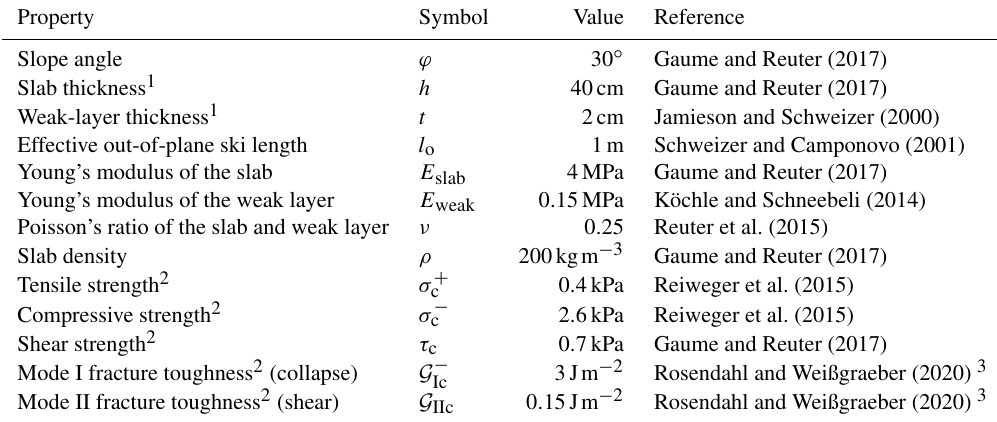
Table 1. Material properties used in parametric studies of the finite fracture mechanics criterion. Property